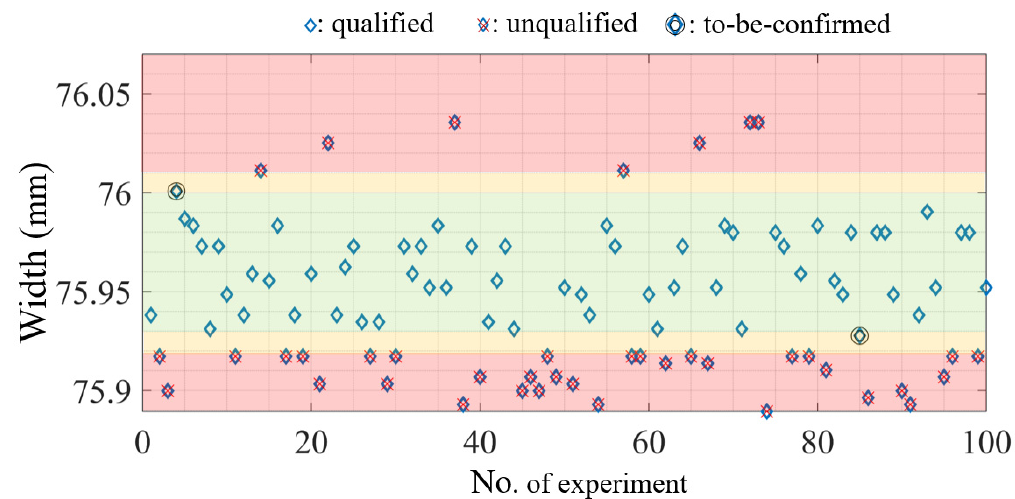
Figure 9. Areas of “qualified” (in green ), “unqualified” (in red ), and “to-be-confirmed” (in yellow ) for W1.